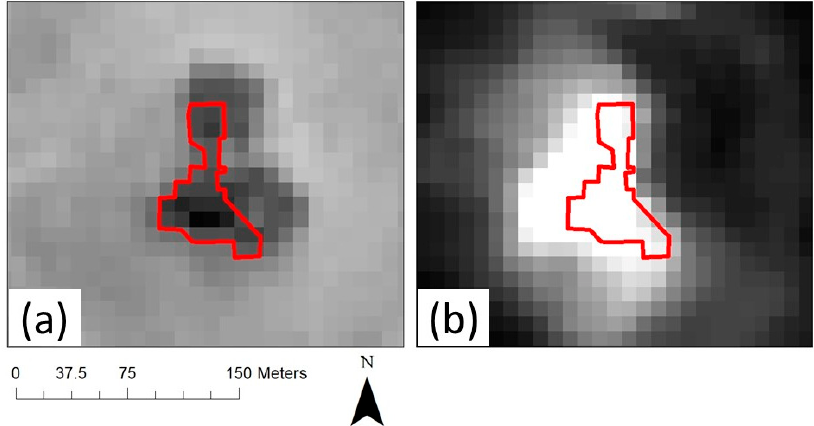
Figure 1. Great care had to be taken in delineating supervised data (polygons) to account for spatial misalignment of data collected by di ff erent sensors. Here, a patch of Euclea shrubs is shown using ( a ) Sentinel-2 band 4 (image captured 11 July 2018) and ( b ) Sentinel-1 cross-polarization (VH; image captured 13 July 2018). We aimed to limit the polygons to pixels where the patch, or feature, of interest, as shown by each sensor, overlapped. Table 2. Summary of supervised data. Field data (FD) polygons were visited in research vehicles (ground-truthed). 190 of the original 233 FD polygons were included in the final training dataset. Polygons added via visual interpretation (VI) were not ground-truthed, but rather were identified via visual interpretation of remotely sensed imagery (PASLAR-2, Sentinel-1, and Sentinel-2) only. FD